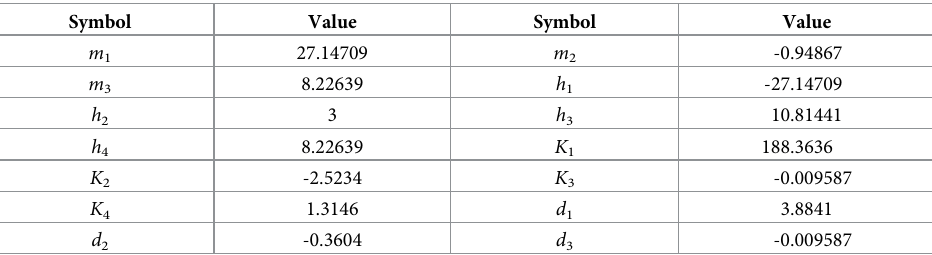
Table 1. Gains used in